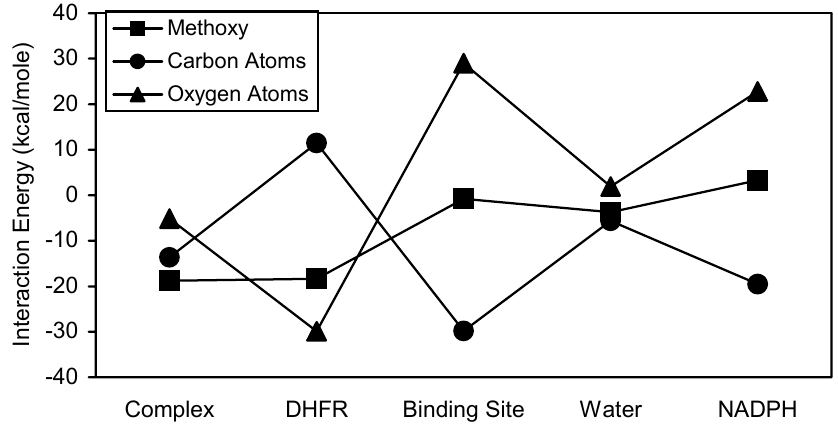
Figure 7. Comparison of interaction energy analysis of the methoxy region of TMP with its carbon and oxygen atoms.